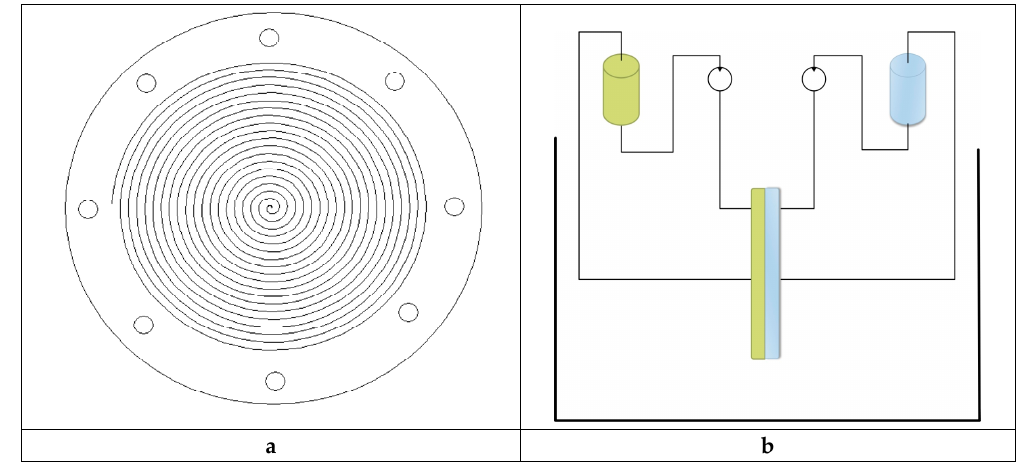
Figure 2. ( a ) PTFE module with Archimedean spiral. ( b ) Scheme of equipment.